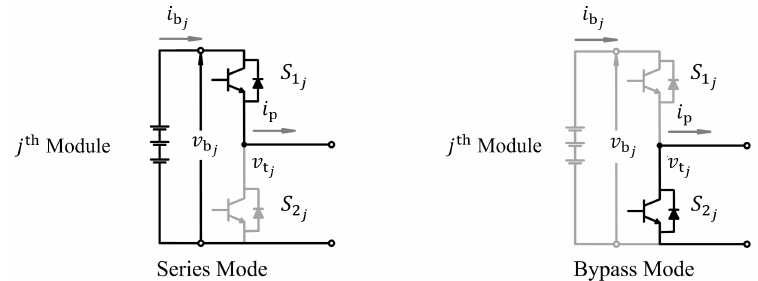
Figure 2. Modes of the j th module.